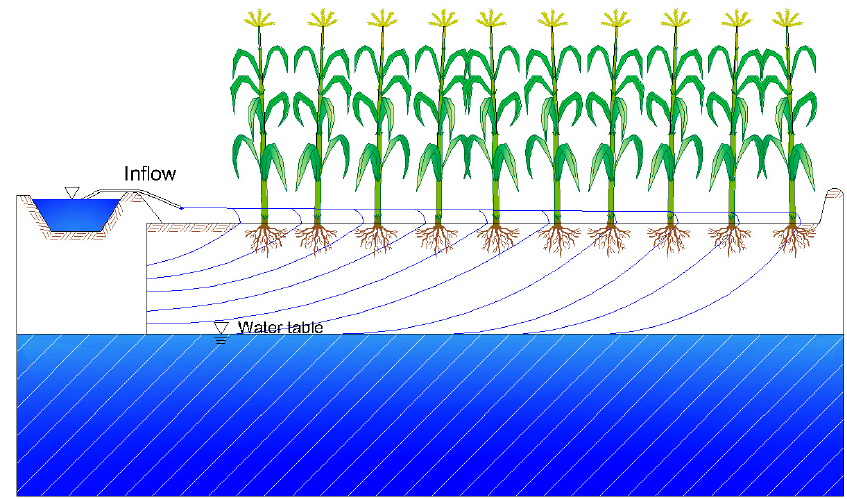
Figure 1. Irrigation scheme in soils with shallow water table.